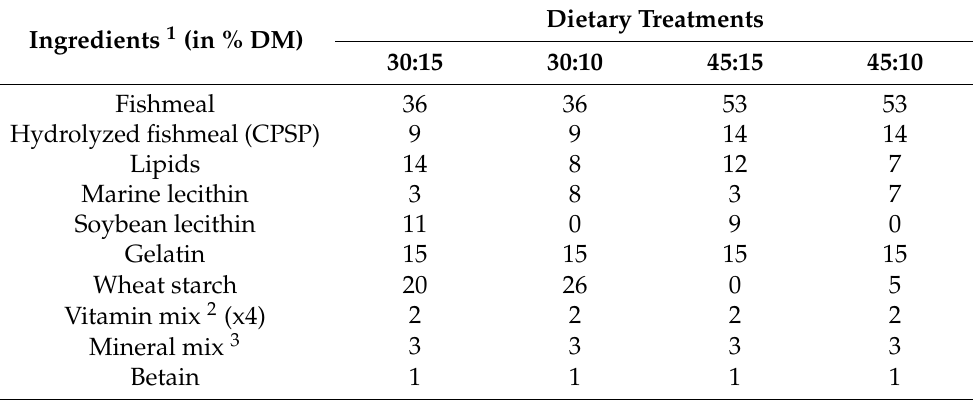
Table 1. Composition of the experimental diets. Dietary treatment codes correspond to the pro- tein:lipid level included in tested diets. DM, dry